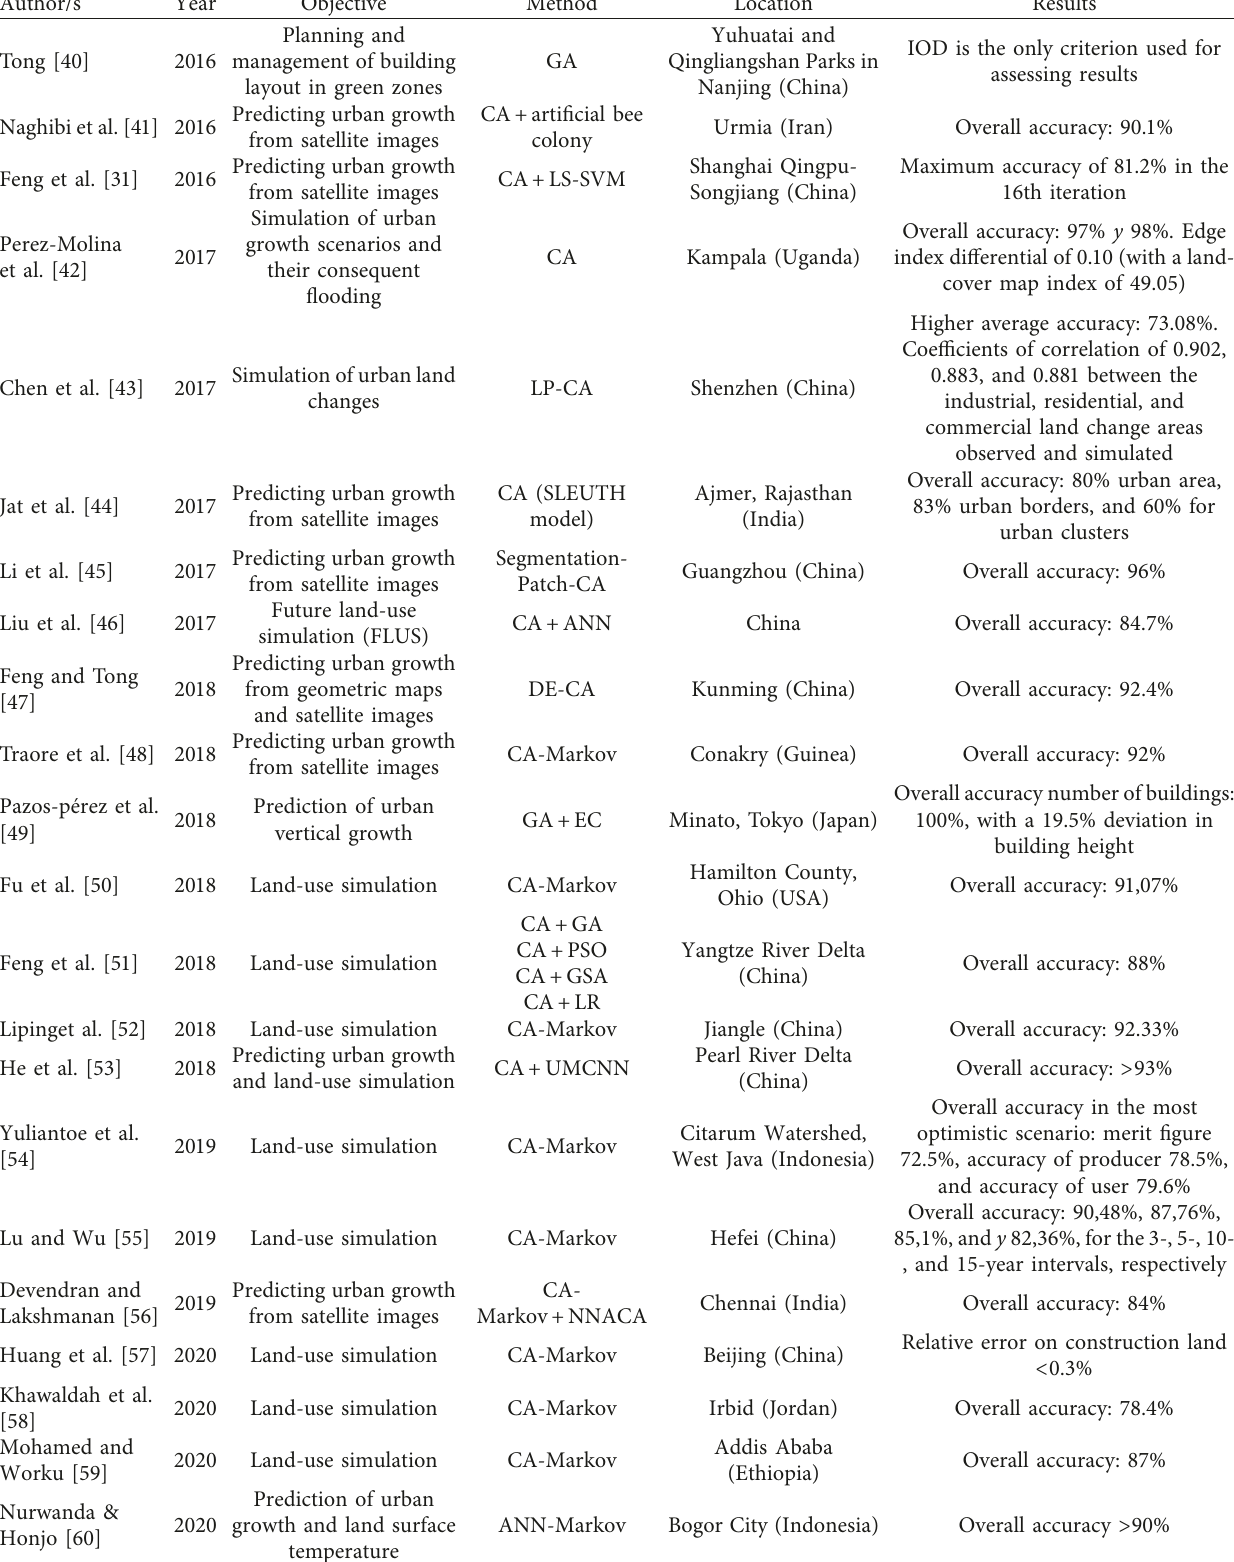
Table 1: Summary table of research